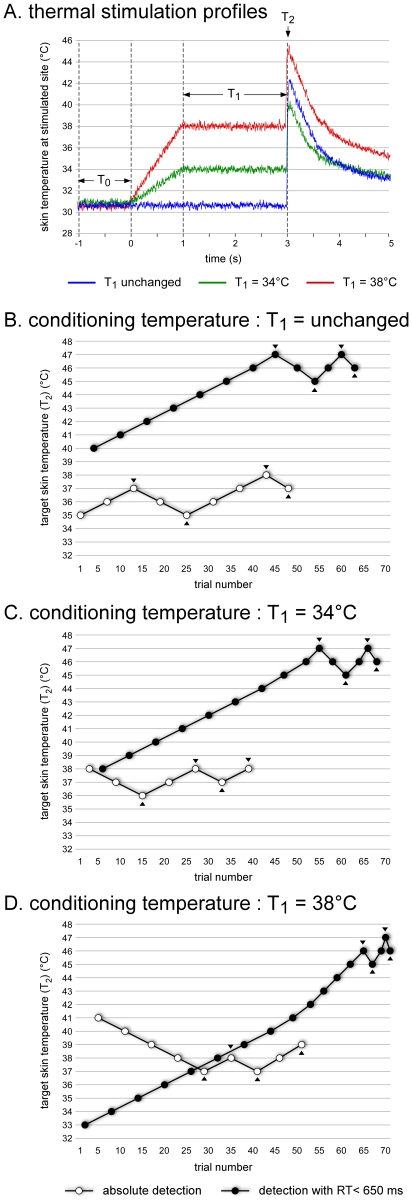
Experimental paradigm.A. Thermal stimuli were applied to the dorsum of the non-dominant hand using a CO2 laser (beam diameter: 6 mm). The data shown corresponds to an actual measurement of skin temperature performed by the radiometer in three different trials (x-axis: time; y-axis: skin temperature). After measuring the baseline skin temperature for one second (T0), the stimulated area was raised to the conditioning skin temperature using a 1-s heating ramp and was maintained at that temperature for 2 seconds (T1). Three different conditioning skin temperatures were used: T1 = unchanged (blue), T1 = 34°C (green) and (c) T1 = 38°C (red). Following this conditioning of the stimulated area, the test stimulus (T2) was applied, consisting of a 10-ms heating ramp followed by a 40-ms plateau. B–D: The staircase procedure used to estimate Aδ- and C-fibre thresholds (one subject shown as example). Participants were asked to respond as quickly as possible by pressing a button held in the dominant hand when perceiving the test stimulus (T2). Reaction times were used to discriminate between responses triggered by C-fibre input (reaction-time ≥650 ms) and responses triggered by Aδ-fibre input (reaction-time <650 ms). For all three conditions (Panel B: T1 = unchanged, Panel C: T1 = 34°C and Panel D: T1 = 38°C), an adaptive staircase algorithm was used to estimate (1) the absolute detection threshold assumed to reflect the detection threshold of C-fibre input and (2) the detection threshold of responses with a reaction-time <650 ms assumed to reflect the detection threshold of Aδ-fibre input. The six staircases required for this procedure were presented in an interleaved fashion, such as to avoid order effects related to habituation and/or sensitization as well as a possible response bias due to anticipation.